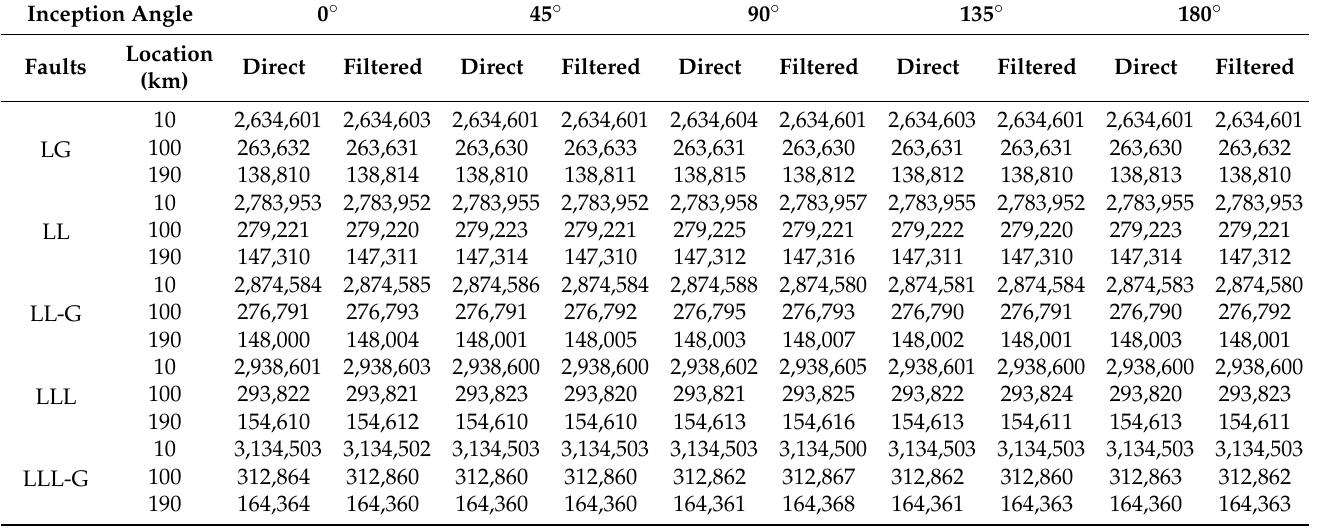
Table A5. Max singular values of FRFT-SVD results for direct and filtered current signals at various faults and inception angles with R = 50 Ω